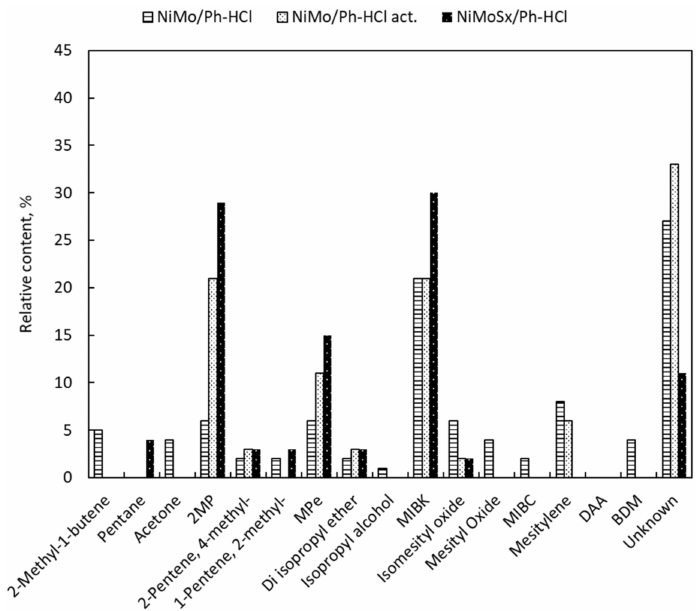
Figure 8. Compounds present in the organic liquid product for the tests using NiMo/Ph-HCl type catalysts. NiMo/Ph-HCl catalyst was used directly, NiMo/Ph-HCl catalyst was previously reduced in hydrogen atmosphere and NiMoSx/Ph-HCl material was previously treated for the sulfidation of the metal